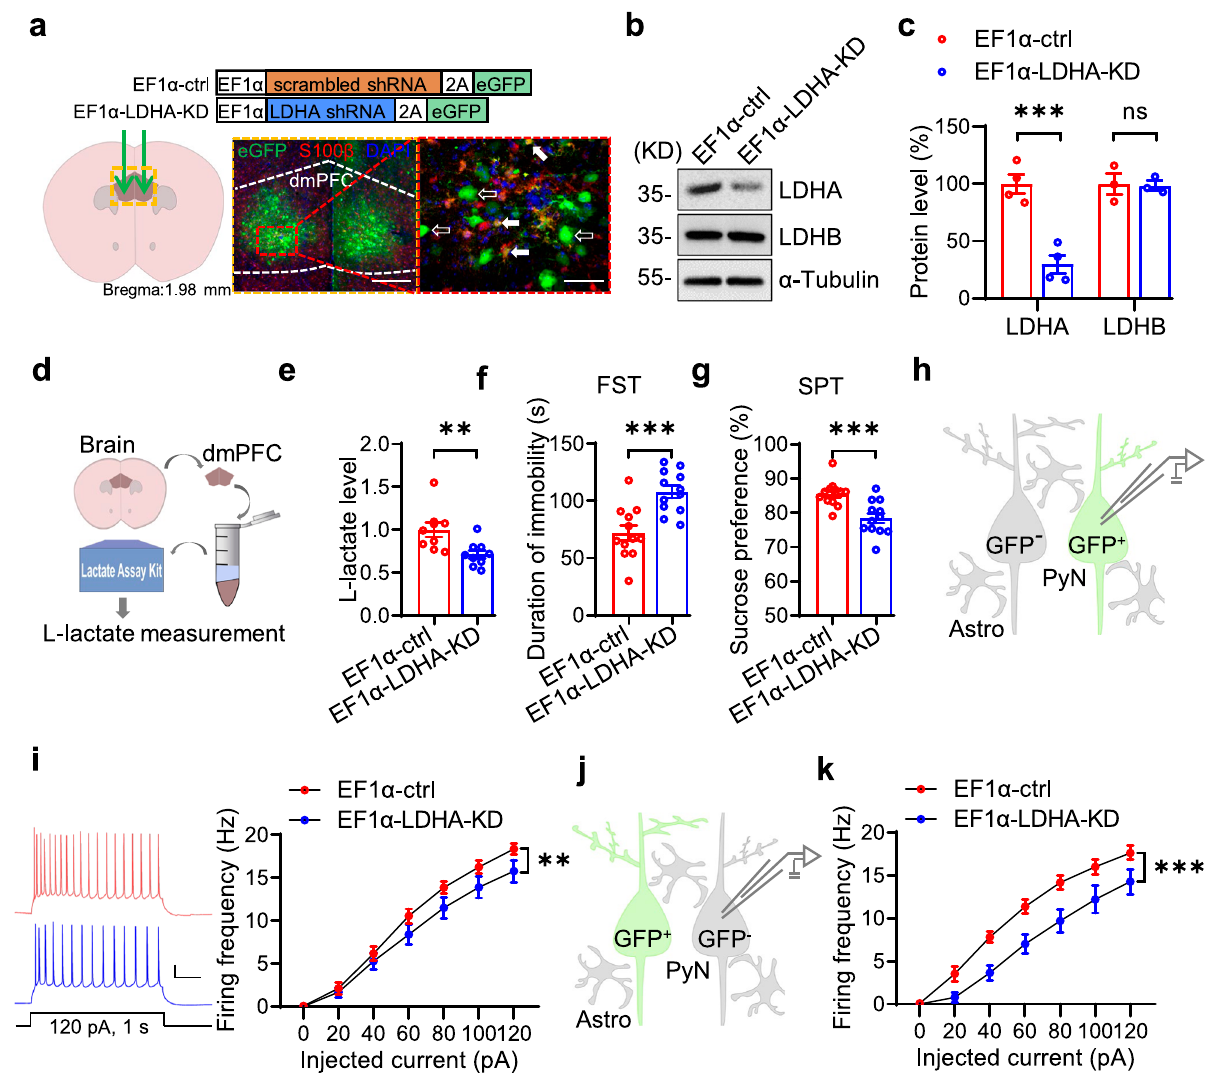
Fig. 3 | Knockdown of LDHA in the dmPFC leads to depressive-like behaviors. diagram of recording of GFP + neurons in dmPFC region. PyN pyramidal neuron, a Top,schematicsofAAVvectors;bottom,illustrationofbilateralviralinjectionsin Astroastrocyte. i Compromised neuronalexcitabilityof GFP + neurons indmPFC of EF1 α -LDHA-KD mice. Left, representative fi ring traces. Scale bars: 0.2s, 20mV. dmPFC region (stained with antibody against S100 β and DAPI). White solid arrows Right,quantitativedata. n =16and18neuronsfrom5EF1 α -ctrland5EF1 α -LDHA-KD denote GFP + and S100 β + cells; white hollow arrows denote GFP + and S100 β − cells. mice, respectively. Two-way ANOVA, gene effect, F (1,224) =10.62, p =0.0013. Scale bars: left, 200 µ m; right, 50 µ m. b Representative Western blot images. j schematic diagram of recording of GFP − neurons in dmPFC region. c Quantitative analysis of data in ( b ). n =4 and 3 mice per group for LDHA and k Compromised neuronal excitability ofGFP − neurons indmPFC of EF1 α -LDHA-KD LDHB, respectively. Student ’ s t -test, for LDHA, t (6) = 6.197, p =0.0008; for LDHB, t (4) =0.1517, p =0.8868. d Schematic work fl ow of L-lactate measurement. mice. Left, representative fi ring traces. Scale bars: 0.2s, 20mV. Right, quantitative e Reduced L-lactate levels in dmPFC of EF1 α -LDHA-KD mice. n =9 mice per group. data. n =11 and 14 neurons from 5 EF1 α -ctrl and 5 EF1 α -LDHA-KD mice. Two-way ANOVA, gene effect, F (1,161) =36.83, p =0.0000. Data were shown as mean±SEM. Student ’ s t -test, t (16) =2.993, p =0.0086. f Increased immobility duration in EF1 α - LDHA-KD mice in FST test. n =12 mice per genotype. Student ’ s t -test, t (22) =4.26, ** p <0.01, *** p <0.001; ns, no signi fi cant difference. Source data are provided as a p =0.0003. g Decreased sucrose preference in EF1 α -LDHA-KD mice in SPT test. Source Data fi p =0.0007. h Schematic n =12 mice per genotype. Student ’ s t -test, t (22) =3.937,